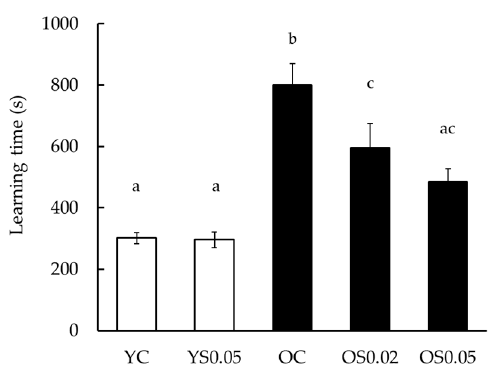
Figure 2. The effect of sesame lignans on passive avoidance task in young and old mice. Values are the mean ± SEM. Statistical analyses were performed using a one-way ANOVA followed by a Tukey–Kramer post hoc analysis. Different letters indicate significant differences ( p < 0.05). Experimental groups are indicated as: Young control, fed basal diet (YC, n = 19), young, fed basal diet supplemented with 0.05% sesame lignans (YS0.05, n = 17), old control, fed basal diet (OC, n = 19), old, fed basal diet supplemented with 0.02% sesame lignans (OS0.02, n = 12), and old, fed diet supplemented with 0.05% sesame lignans (OS0.05, n = 21). Mice with abnormal motor function (one mouse in YS0.05, three mice in OC, and one mouse in OS0.05 groups) were excluded from analysis. The time spent in the light room in each 300-s trial was recorded and then deducted from 300 s. The calculated time of each trial, up to five times, was summed as the time needed for learning and the total time was expressed as “learning time”.